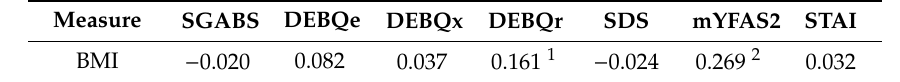
Table 2. Pearson correlation coe ffi cients among the questionnaire measures and body mass index (BMI). Measure SGABS DEBQe DEBQx DEBQr SDS mYFAS2 STAI BMI − 0.020 0.082 0.037 0.161 1 − 0.024 0.269 2